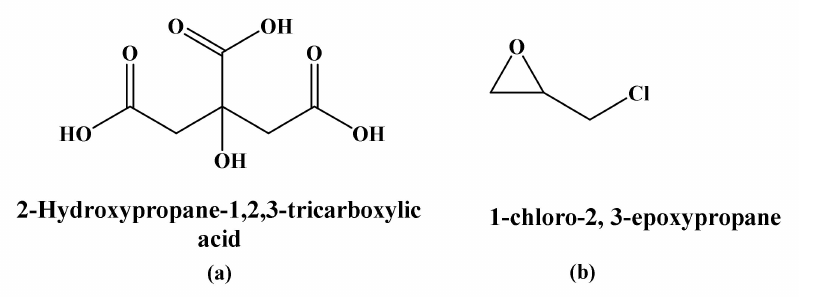
Figure 7. Chemical structures of crosslinking agents: ( a ) Citric acid and ( b )